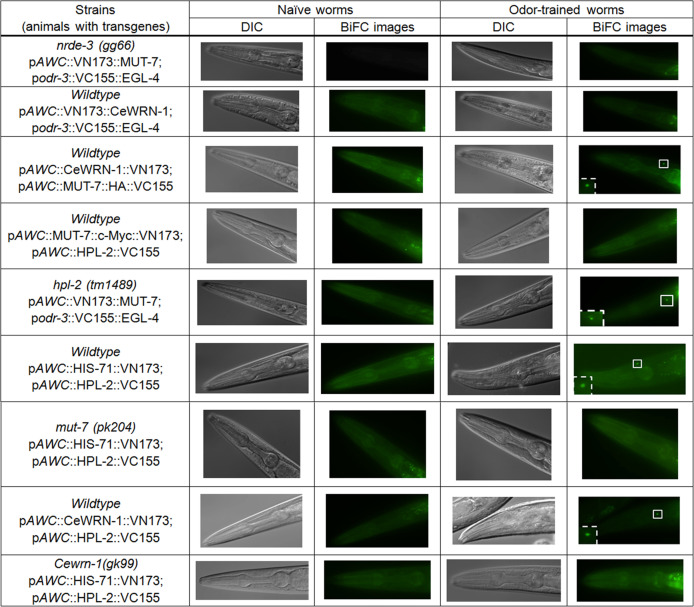
Images of BiFC screening results.All representative fluorescent images related to Figure 4A from naïve and odor-trained worms are shown.